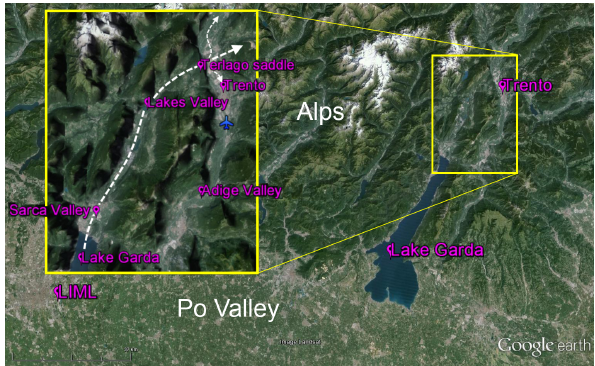
Figure 1. Localization of the study area (small yellow box) near the city of Trento in the south-eastern Italian Alps; Lake Garda and Milan sounding station (LIML) are also indicated. A close-up view on the study area is provided in the large yellow box on the left. Here the dashed white arrow represents the Ora del Garda flowing from Lake Garda’s shoreline, along the Sarca and the Lakes Valley, and finally into the Adige Valley across the Terlago saddle (see labels). Background images: © 2014 Google Earth, © 2014 European Space Imaging, © 2014 DigitalGlobe, © 2014 CNES–SPOT